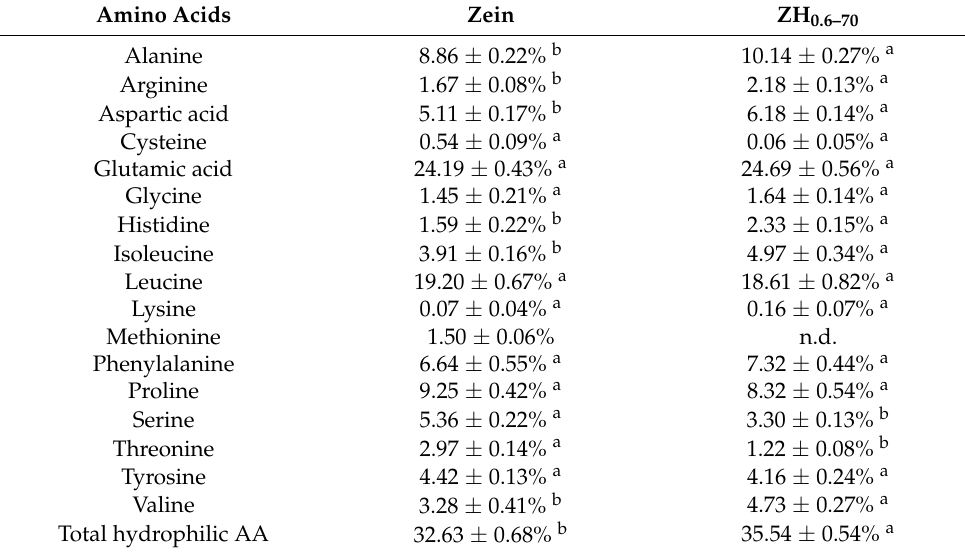
Table 1. Amino acids profiles of zein and ZH 0.6–70 (n = 3).